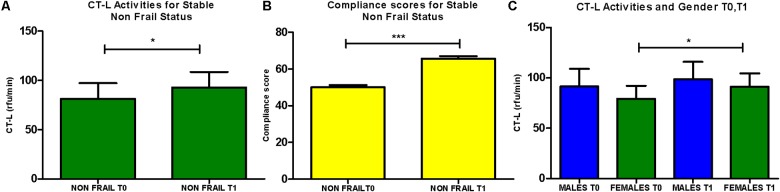
(A) CT-L activity levels were analyzed for the subgroup of subjects retaining non-frail status before after the intervention (n = 76; paired t-test, Mean ± SEM). (B) Compliance to the Mediterranean diet of subjects retaining non-frail status before after the intervention (n = 76; paired t-test, Mean ± SEM). (C) CT-L activity levels were determined in the subgroups of males and females before and after intervention (n = 51, n = 68, respectively, paired t-test, Mean ± SEM). ∗p < 0.05 and ∗∗∗p < 0.001.